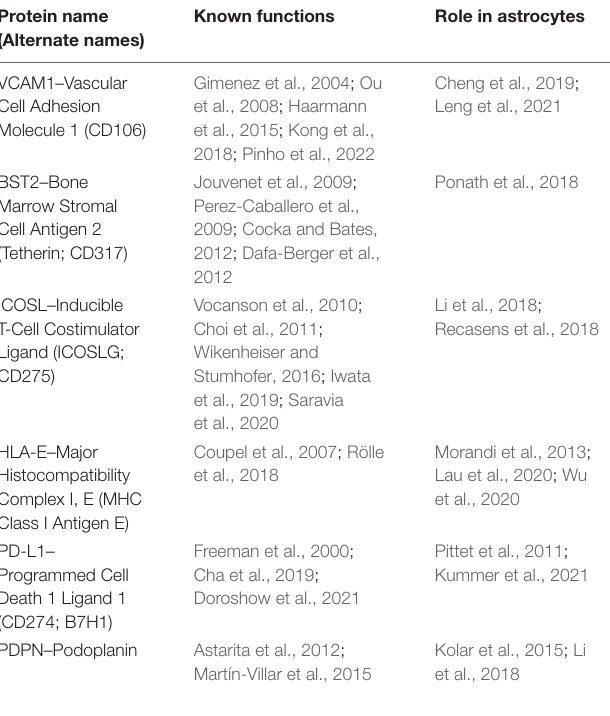
TABLE 1 | Publications describing known functions of novel reactive astrocyte